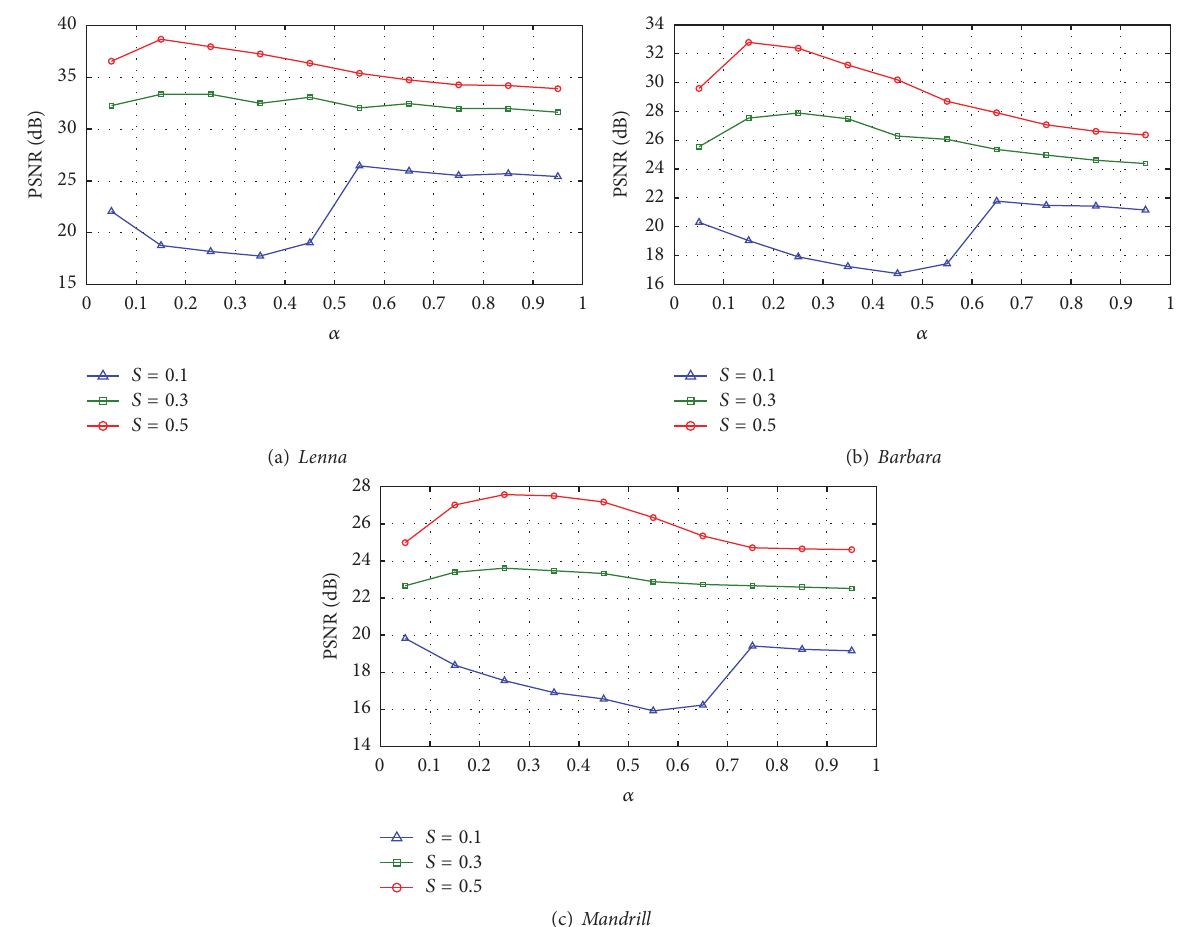
Figure 4: PSNR curves of the reconstructed images with the different threshold 𝛼 when the sampling rate 𝑆 is 0.1, 0.3, and 0.5, respectively. region improves effectively, but otherwise for other